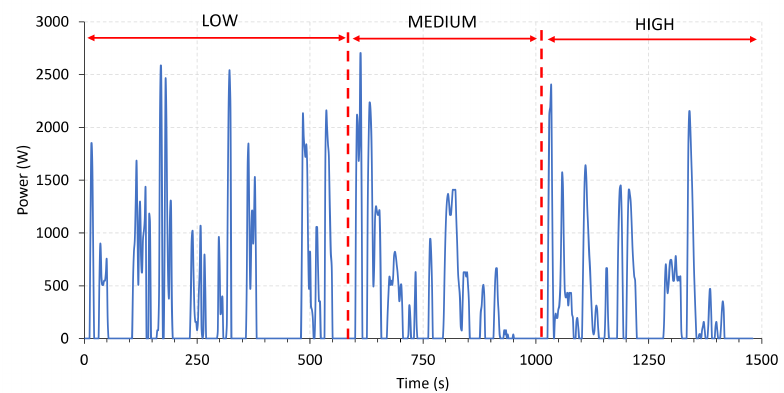
Figure 5. Power profile for WLTP class 2 driving profile.